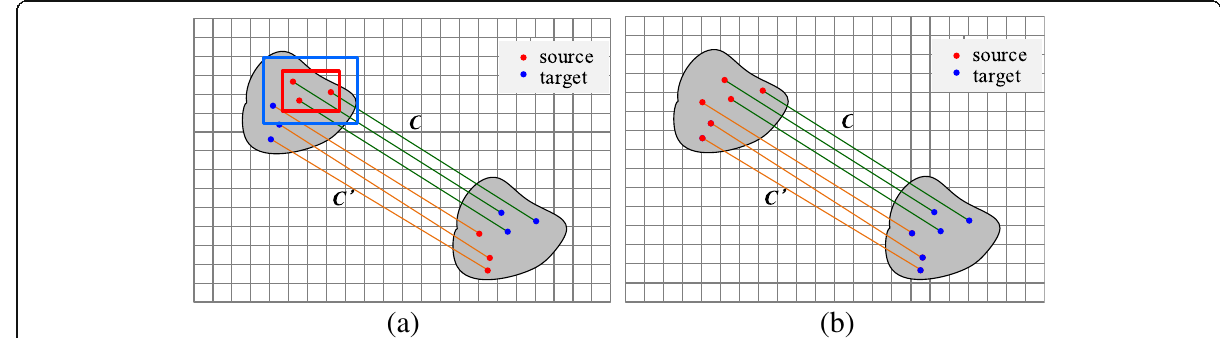
Fig. 4 An example for clustering profile. a The matching pairs stay in the opposite subgroup corresponding to group C and group C ′ in the same region. b Clustering